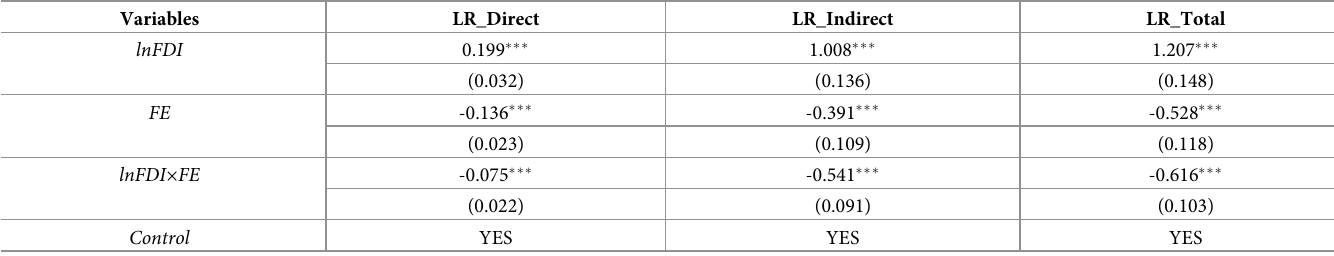
Table 8. The direct and indirect effects of SDM